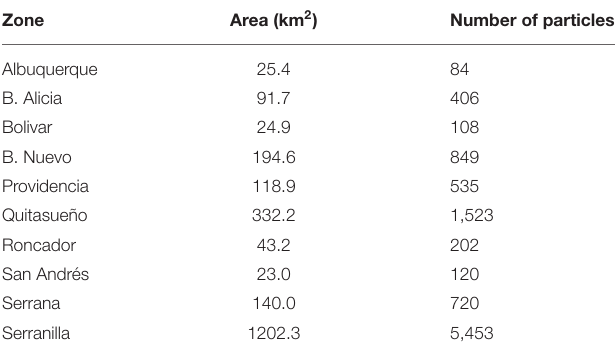
TABLE 2 | Area of each zone and number of particles released.